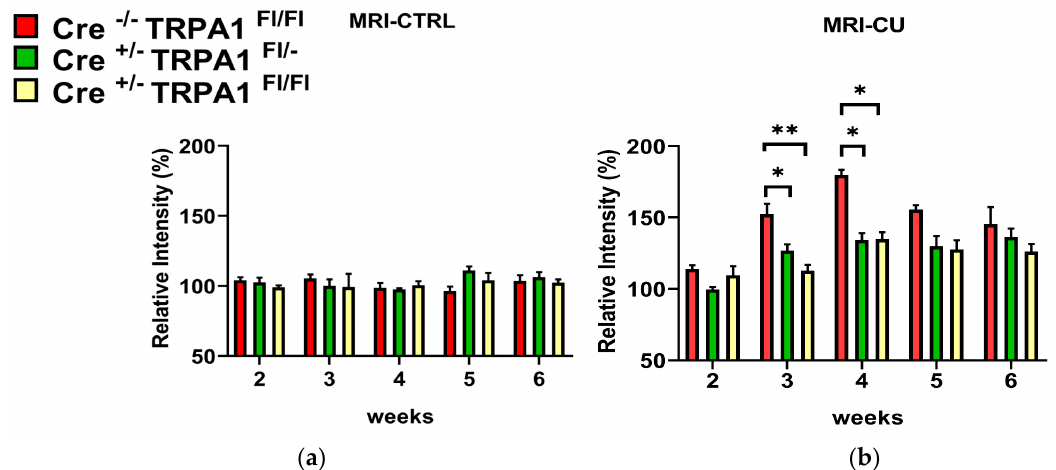
Figure 3. Changes of signal intensity in the medial corpus callosum measured by magnetic resonance imaging between week 2 and 6 of cuprizone treatment in (a) control (CTRL) and (b) cuprizone-treated (CU) groups of GFAP-Cre − / − TRPA1 Fl/Fl , GFAP-Cre +/ − TRPA1 Fl/ − and GFAP-Cre +/ − TRPA1 Fl/Fl mice. Data are means ± S.E.M. of images obtained from animals (n = 4/group). The signal intensities were normalized to the baseline values (100%) for each animal and indicated by percentages of relative intensity. Asterisks show statistically significant differences between respective CU and CTRL groups (* p < 0.05, ** p < 0.01).